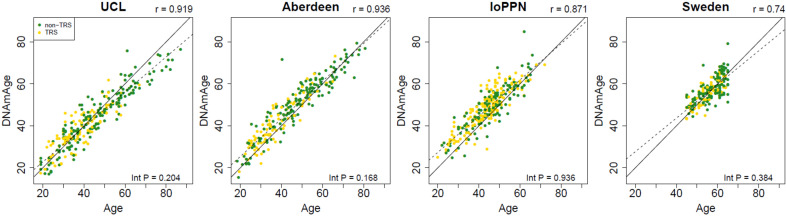
Scatterplots of DNAmAge derived from the DNA methylation data against actual chronological age for each of the cohorts.DNAmAge was calculated using the algorithm described by Horvath, 2013. Each point represents an individual and is colored by medication status (yellow = schizophrenia cases not prescribed clozapine, green = treatment-resistant schizophrenia cases prescribed clozapine). The solid diagonal line depicts x=y, that is, where the estimated and actual values are the same. The dashed diagonal line depicts the line of best fit. Presented at the top of the graph is the Pearson’s correlation coefficient (r) between the estimated and actual age across all samples in that cohort. Also shown in the bottom right-hand corner of each panel is an interaction p-value from a test for different correlations between DNAmAge and actual age for schizophrenia patients prescribed clozapine and schizophrenia patients prescribed alternative medications.